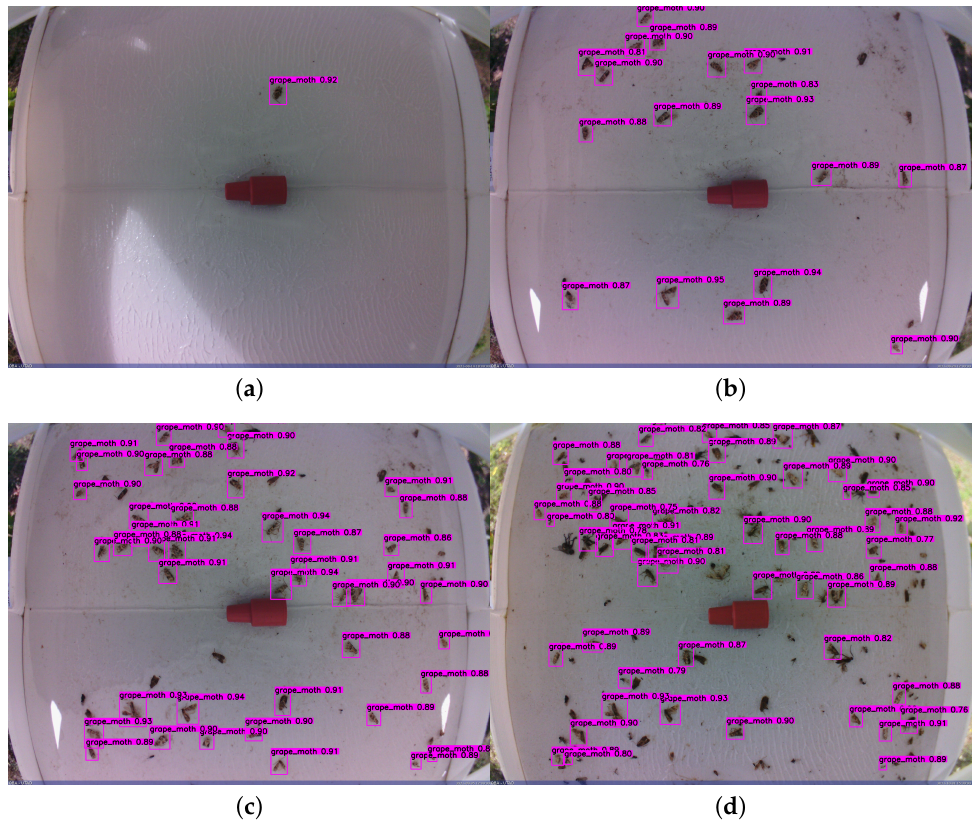
Figure 12. Evolution of the number of individuals of Grapevine moth males caught in the trap: ( a ) 18 August—1 detection; ( b ) 24 August—18 detections; ( c ) 27 August—43 detections; ( d ) 5 September— 58 detections.